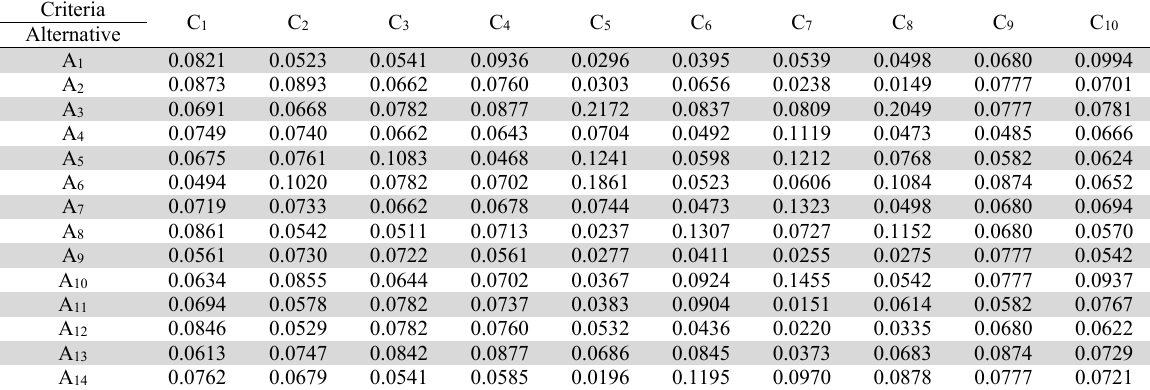
Normalized decision matrix Criteria